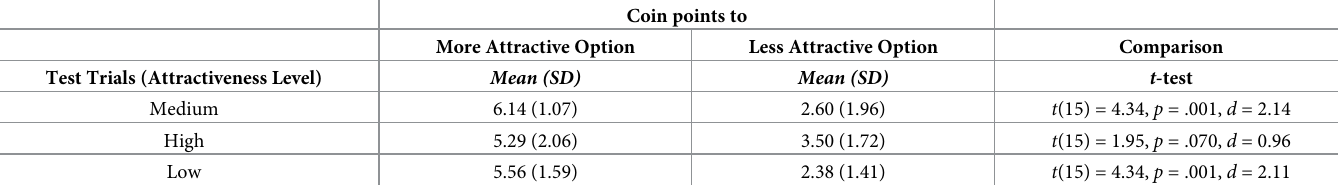
Table 1. Affective reactions (means and standard deviations) in the pilot study depending on whether the coin flip suggested the previously more or less attractively rated